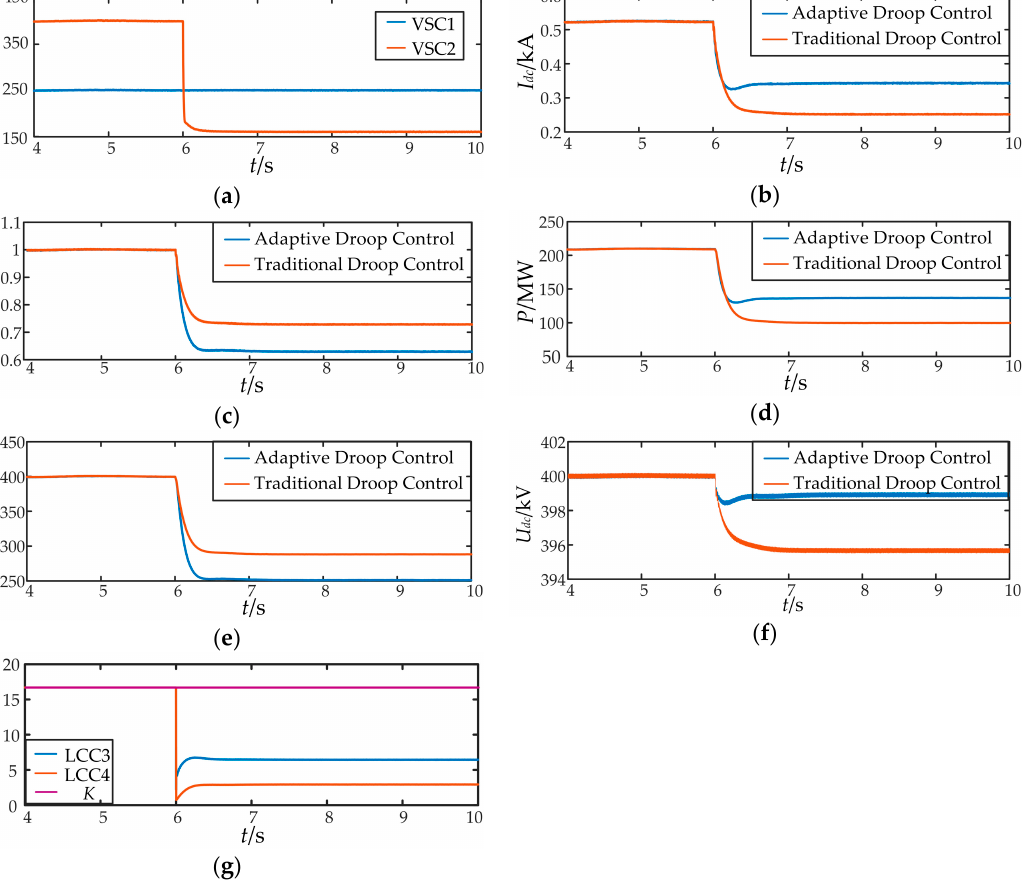
Figure 14. Simulation waveforms of a decrease of active power: ( a ) Active power of VSC1 and VSC2; ( b ) DC current of LCC3; ( c ) DC current of LCC4; ( d ) active power of LCC3; ( e ) active power of LCC4; ( f ) DC voltage; ( g ) adaptive droop coefficient of LCC converter stations .